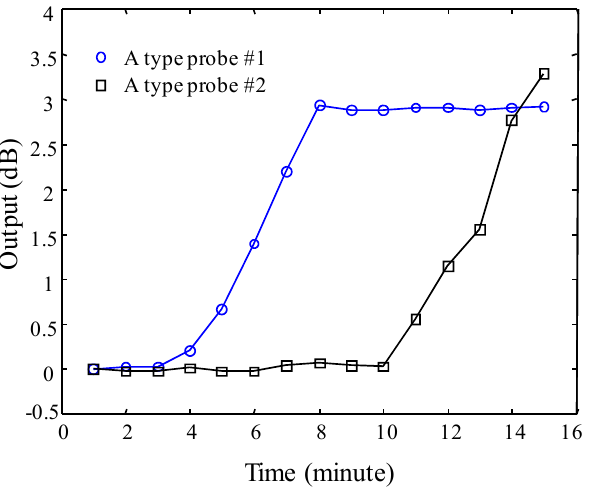
Figure 12. Sensor output of A-type probe as a function of water injection time.